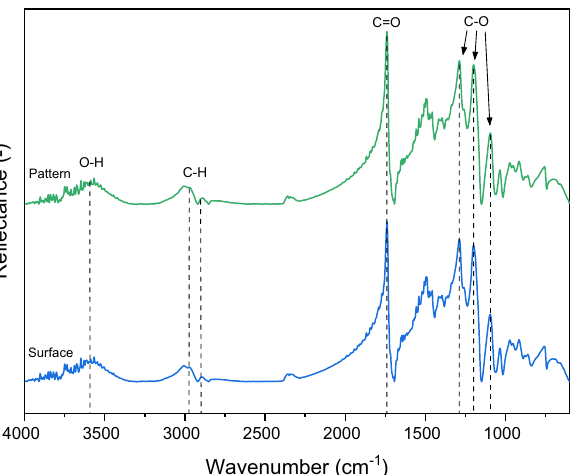
Figure 7. FTIR spectra of the dried hydrogel PHEMA samples on the unmodified (Surface) and nanopatterned surface (Pattern).